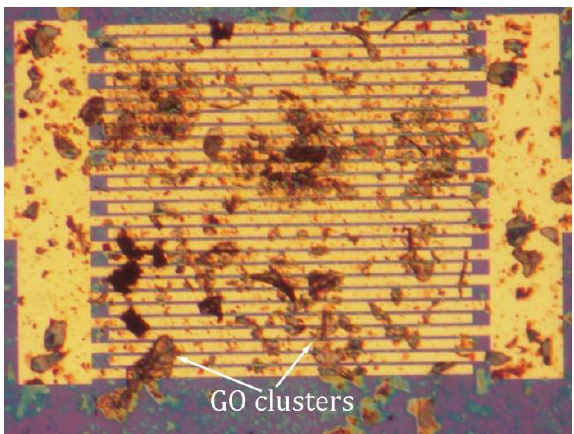
Figure 12. Optical image of graphene oxide (GO), dispersions (in water) on interdigitated elec- trodes over SiO 2 /Si substrate. The GO dispersions (deposited by ultrasonic spray pyrolysis) are agglomerated to form clusters. Reproduced from (Xiaohui Tang, [135]), Copyright 2020, Elsevier.